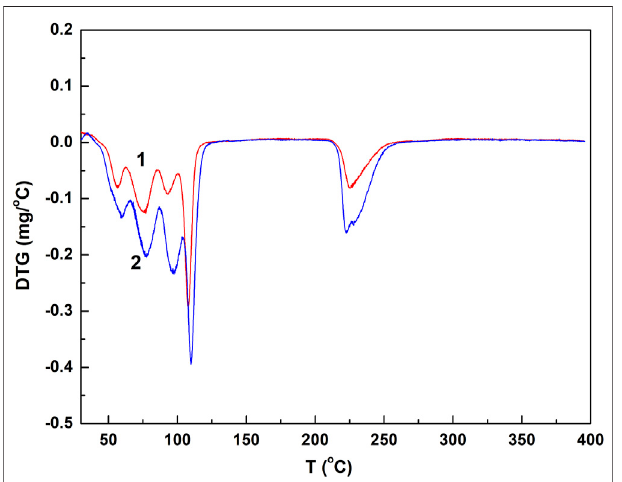
FIGURE 2 | DTG spectrogram of the low- and medium-weight chalcanthite crystals. Note: curves 1 and 2 are DTG pro fi les of low- and medium-weight chalcanthite crystals, respectively.